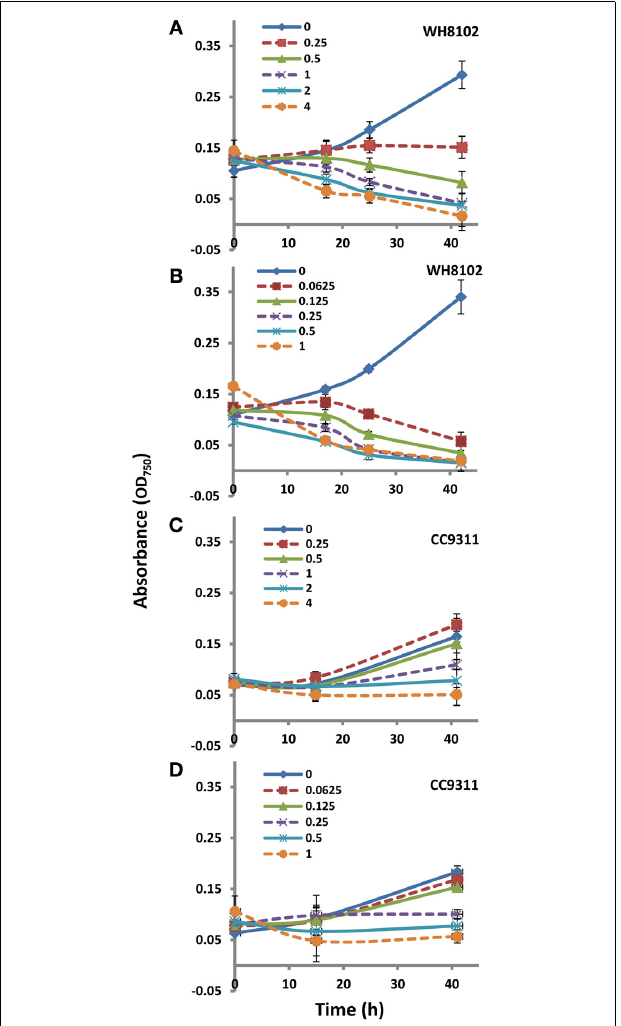
FIGURE A1 | Growth of WH8102 and CC9311 on treatment with EB and MC at concentrations ranging from 0–4 and 0–1 µ g/ml − 1 respectively. (A) Growth of WH8102 on treatment with EB; (B) Growth of WH8102 on treatment with MC; (C) Growth of CC9311 on treatment with EB; (D) Growth of CC9311 on treatment with MC. The axes represent absorbance at 750nm against time in hours. The experiment was conducted in triplicate and the mean plotted. The error bars represent standard deviation.